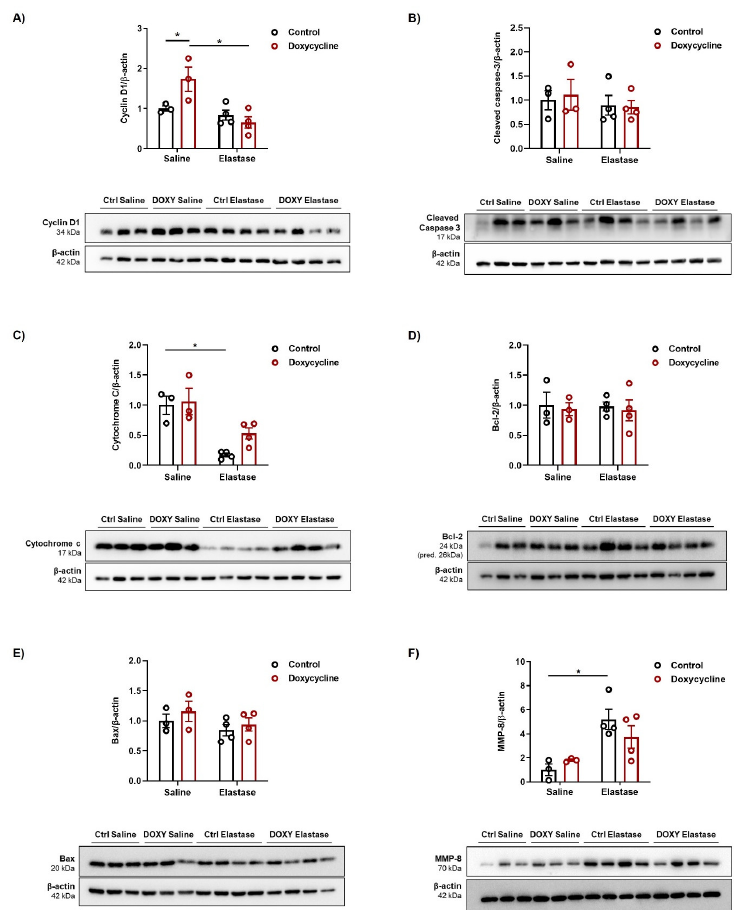
Figure 5. iNOS knockout in AECII cells influences Cytochrome c expression in elastase-treated mice. Western-blot analysis ( n = 3–4) of ( A ) Cyclin D1, ( B ) Cleaved caspase 3, ( C ) Cytochrome c, ( D ) Bcl-2 ( E ) Bax and ( F ) MMP-8 in lung homogenates of saline- or elastase-treated iNos CCSP rtTA2 s -M2 LC1 mice fed either with normal (control, Ctrl) or doxycycline (Doxycycline, DOXY)-containing chow, after the 12-week follow-up period. Data are given as the ratio between the protein of interest and β-actin, standardized to saline control. Graphs show mean ± SEM. * p < 0.05. Two-way ANOVA (with Tukey´s multiple comparisons post-hoc test) was used.